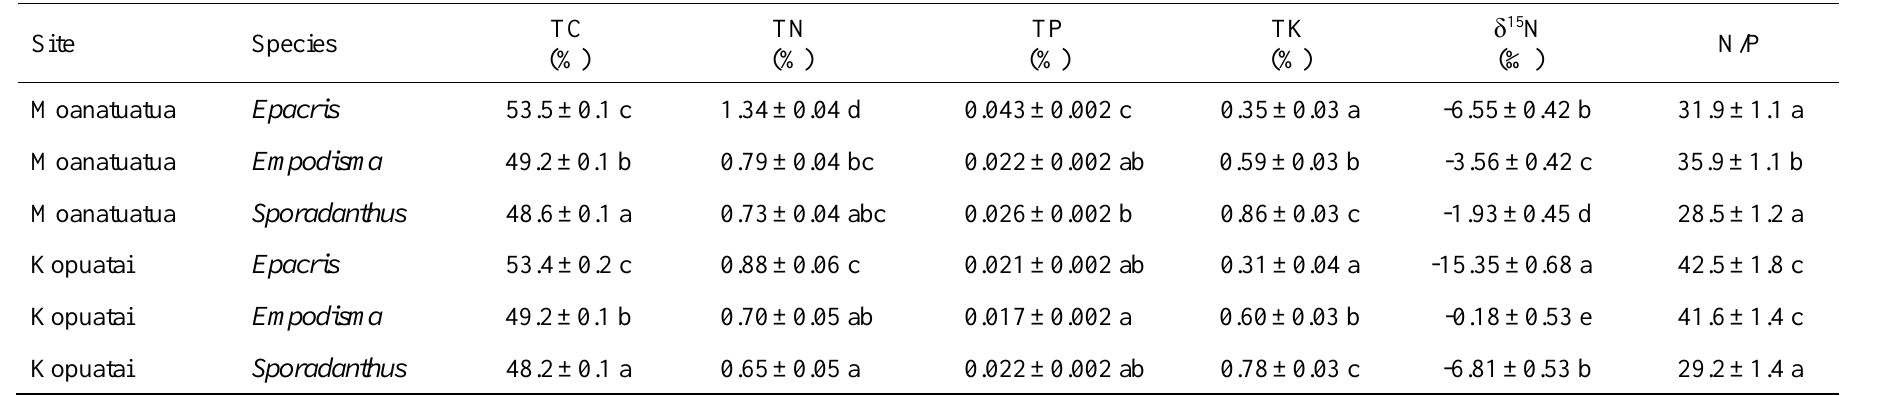
Table 4. Mean (± standard error) for plant foliage isotopic and chemical composition (total carbon (TC), total nitrogen (TN), total phosphorus (TP), total potassium (TK), δ 15 N and nitrogen/phosphorus quotient (N/P)), from the residual maximum likelihood (REML) analysis, for modified (Moanatuatua) and reference (Kopuatai) bogs in 2017. For each variable, means without a letter in common are significantly